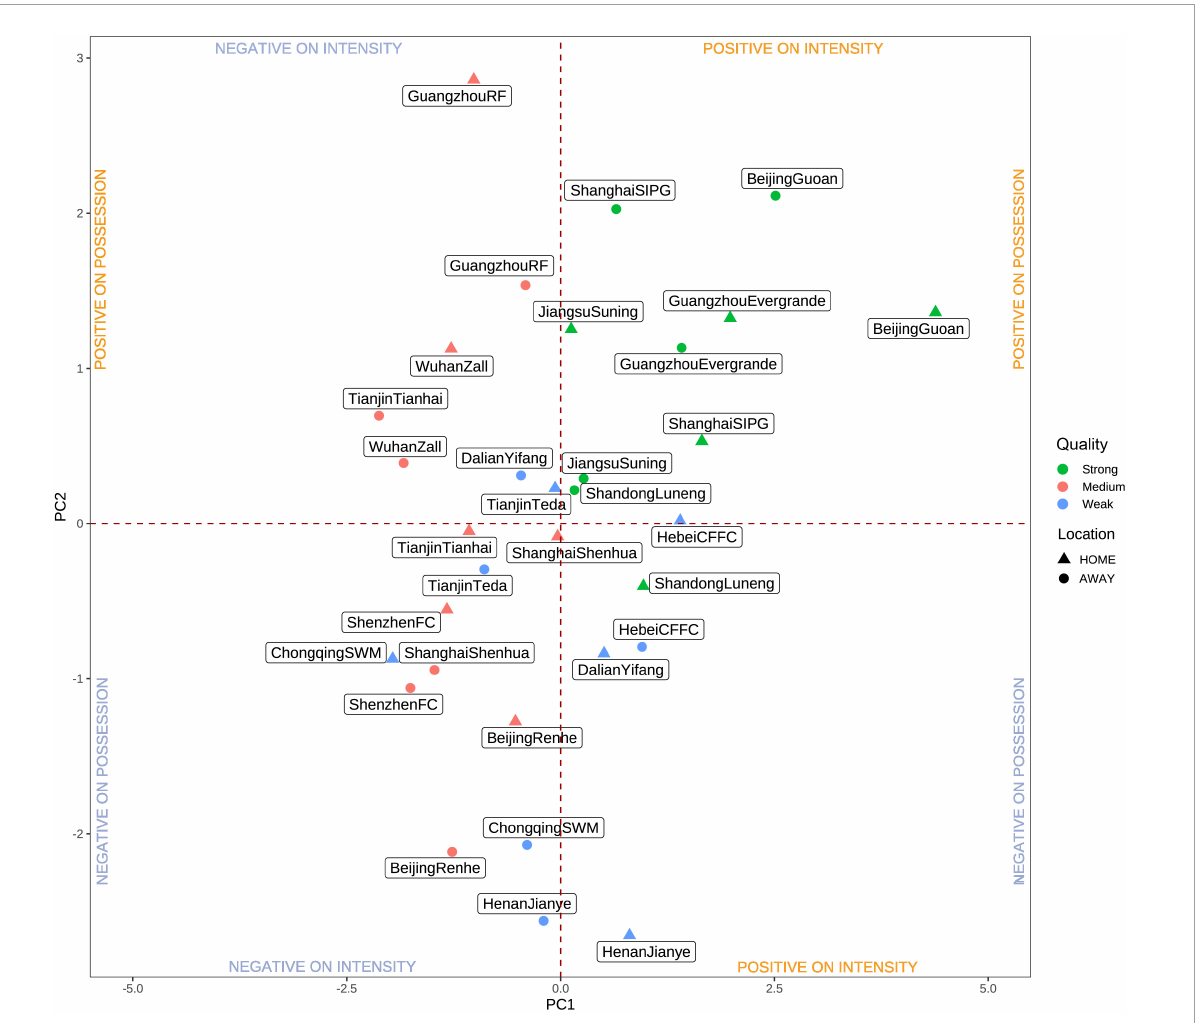
FIGURE3 Combined graph of each team between home and away matches based on the principal components PC 1 and PC2 (X-axis dimension 1; Y-axis dimension 2).